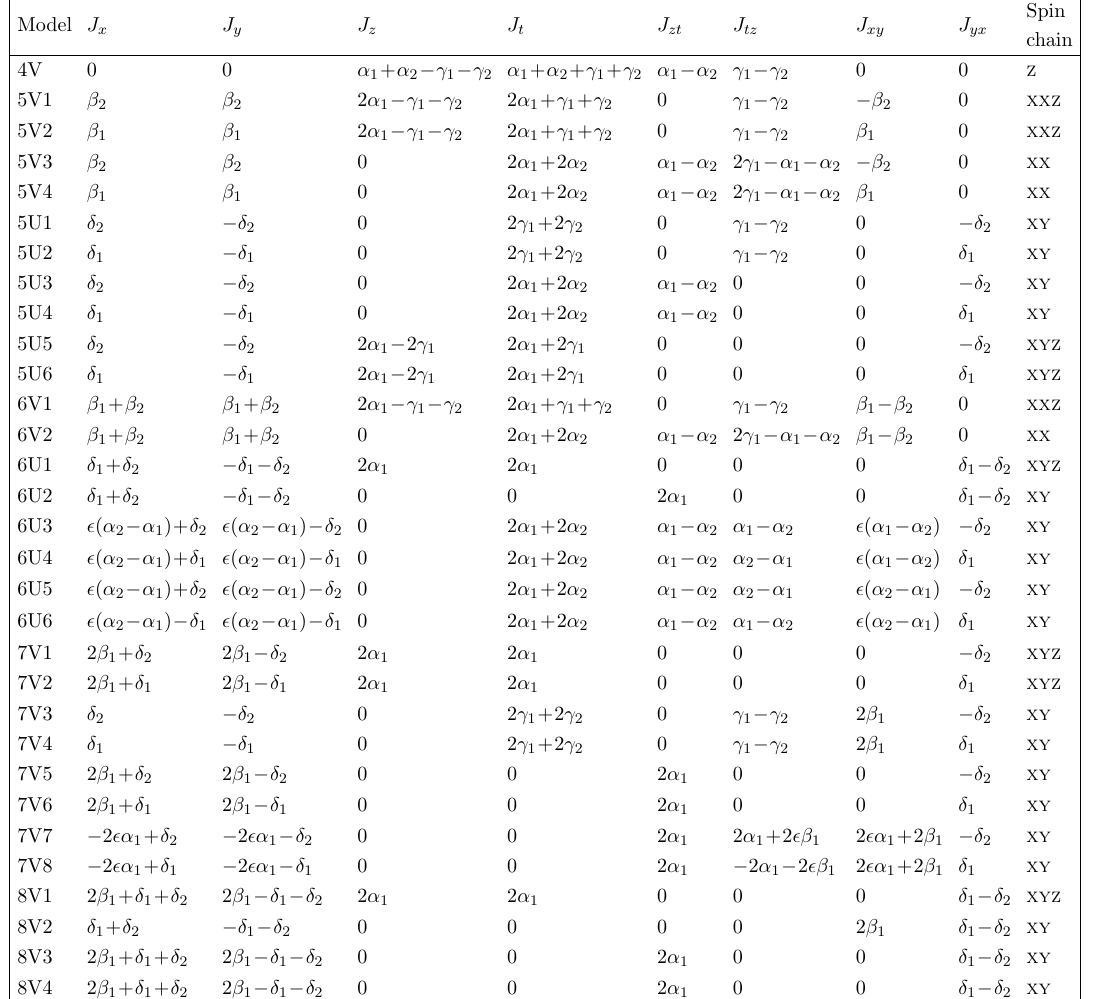
Table 3 . Hamiltonian coe(cid:14)cients for each vertex model and the corresponding spin chains. Notice that the free-fermion models are characterized by J z =